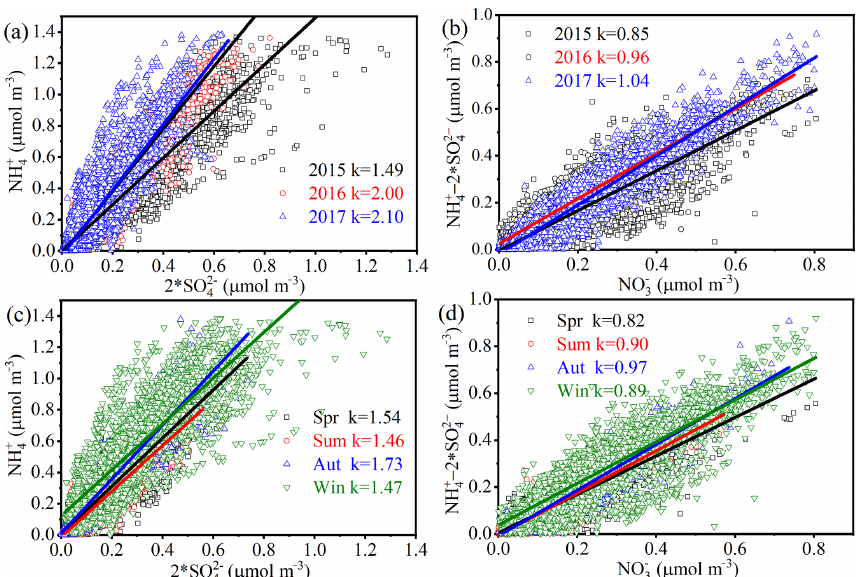
Figure 8. Molar ratio analysis of NSA (nitrate, sulfate and ammonium). (a) Interannual variation in the molar ratio of SO 2 − (b) Interannual variation in the molar ratio of NO − variation in the molar ratio of NO −